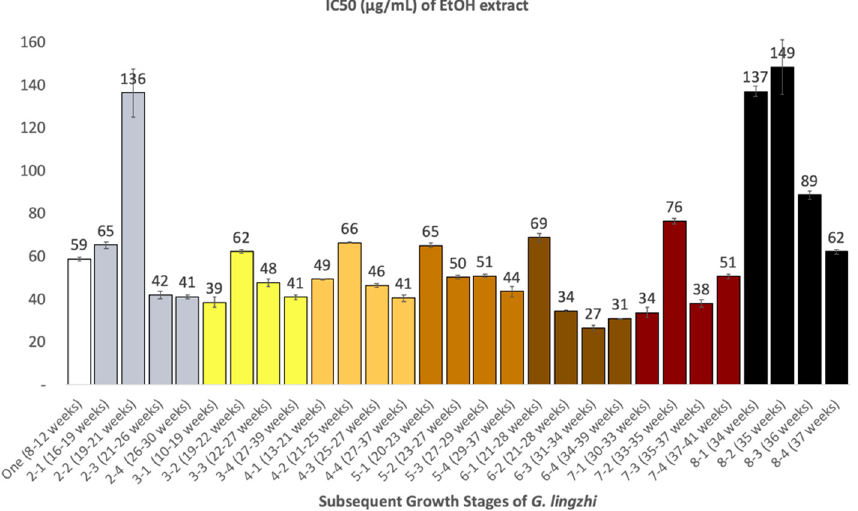
Figure 5. α -Glucosidase inhibitory activity (IC 50 in μ g/mL) of ethanol extract of G. lingzhi at different developmental stages.